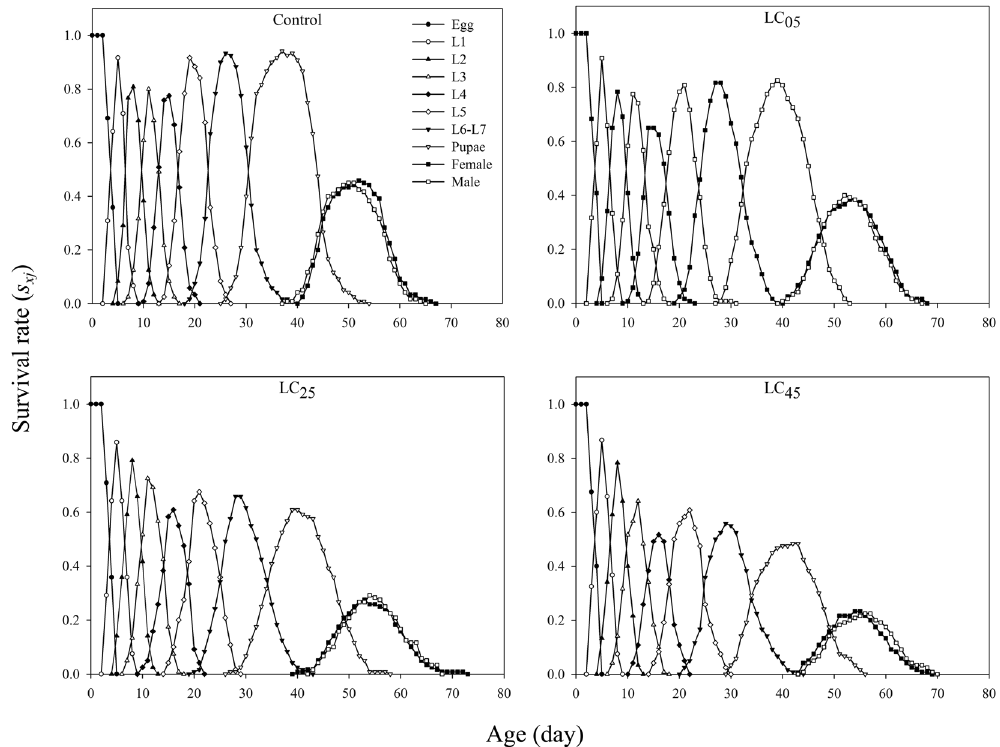
Figure 1. Age-stage specific survival rate ( s xj ) of A. ipsilon after exposure to low-lethal concentrations of chlorantraniliprole.